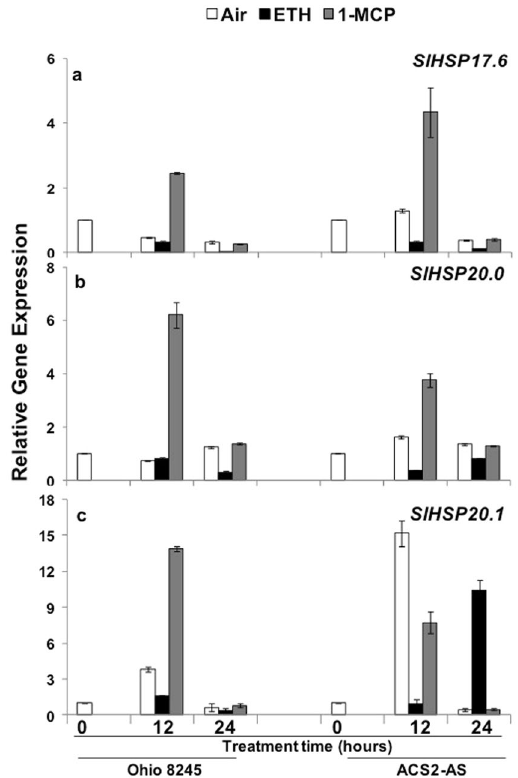
Figure 3. Quantitative RT-PCR expression analysis of class-I SlHSP ( 17 . 6 , 20 . 0 and 20 . 1 ) genes in wild type tomato ( Solanum lycopersicum cv. Ohio8245) and ethylene-deficient genotype (ACS2-AS). Fruits at mature green stage from two genotypes (WT - Ohio8245) and ethylene-deficient genotype (ACS2-AS) were treated with ethylene(ETH), 1-MCP (1-MCP), or left in air. Fruit RNA was isolated from three independent biological samples and Q-PCR analysis was carried out as described in the Materials and Methods section. Error bars indicate standard deviation of data from a minimum of three